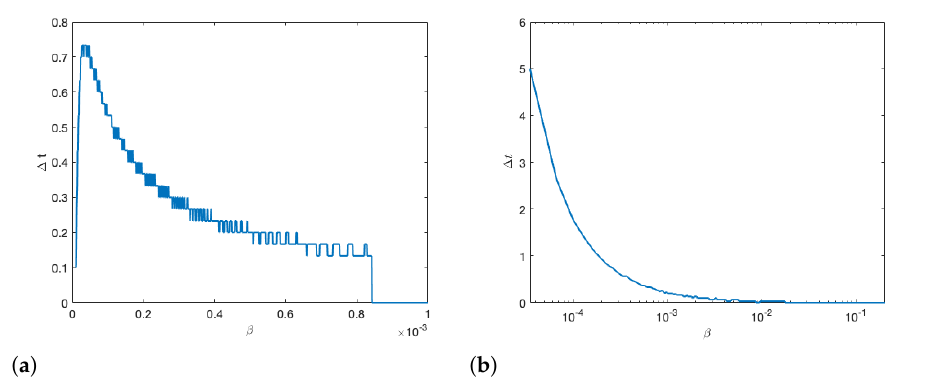
Figure 10. With all other parameters being equal, we change β and measure the time between peak infections in colony 1 and colony 2. We can see that increasing β exhibits exponentially decreases in the time it take an infection to reach colony 2, but the change is quite small. In panel ( a ), we use a drift coefficient of 0.1, and in panel ( b ), we use a drift coefficient of 1 × 10 − 4